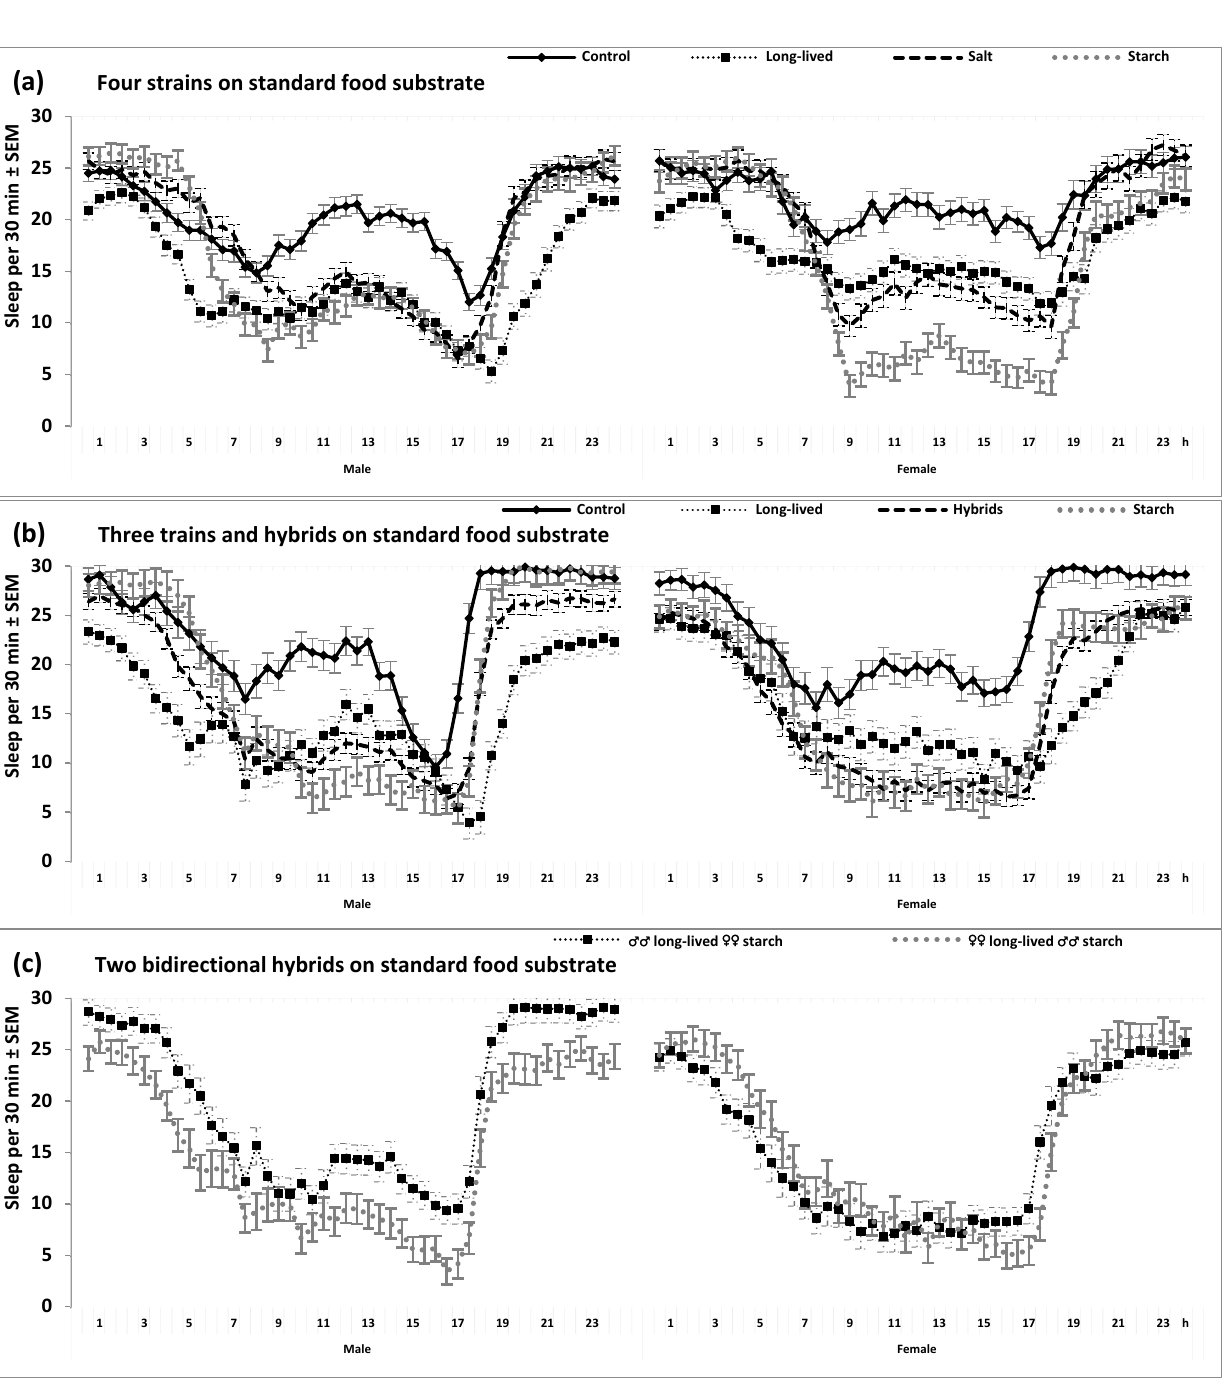
Figure 2. The 24 h sleep patterns. ( a ). From the results of two two-way rANOVAs. ( b , c ): From the results of three-way rANOVAs with another independent factor “Sex” (Male or